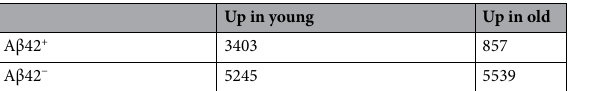
Table 1. Number of genes upregulated in young and old microglia that did and did not phagocytose